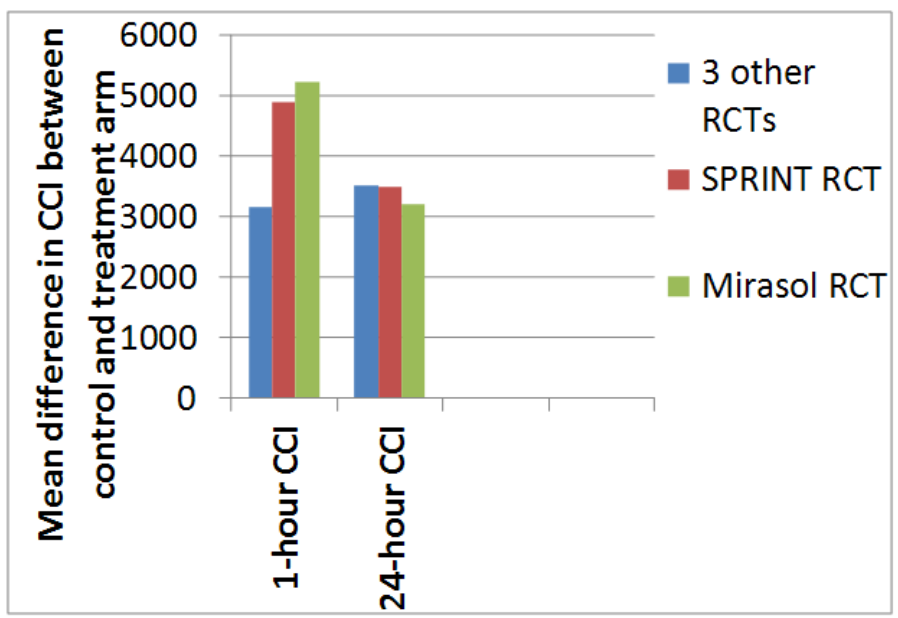
FIGURE 4. Mean difference in the 1- and 24-h CCIs between recipients of non– pathogen-reduced vs. pathogen-reduced platelets in the study of the Mirasol technology[15], the SPRINT RCT of the Intercept technology[32], and across the three other RCTs[14,31,33] of the Intercept technology. Because the SPRINT trial[32] had not reported the SD of the difference for these quantitative outcomes, it could not be integrated with the other RCTs in the meta-analysis[16]. All depicted analyses demonstrate a statistically significant ( p < 0.05) reduction in CCIs secondary to